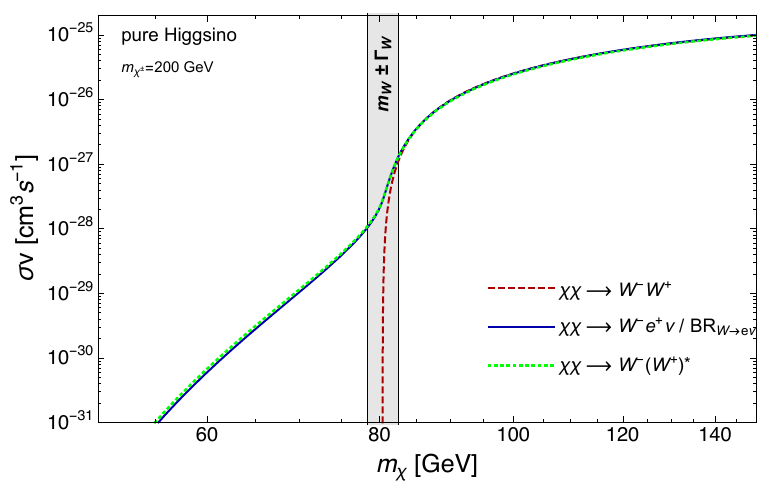
W + W (cid:0) , compared to !